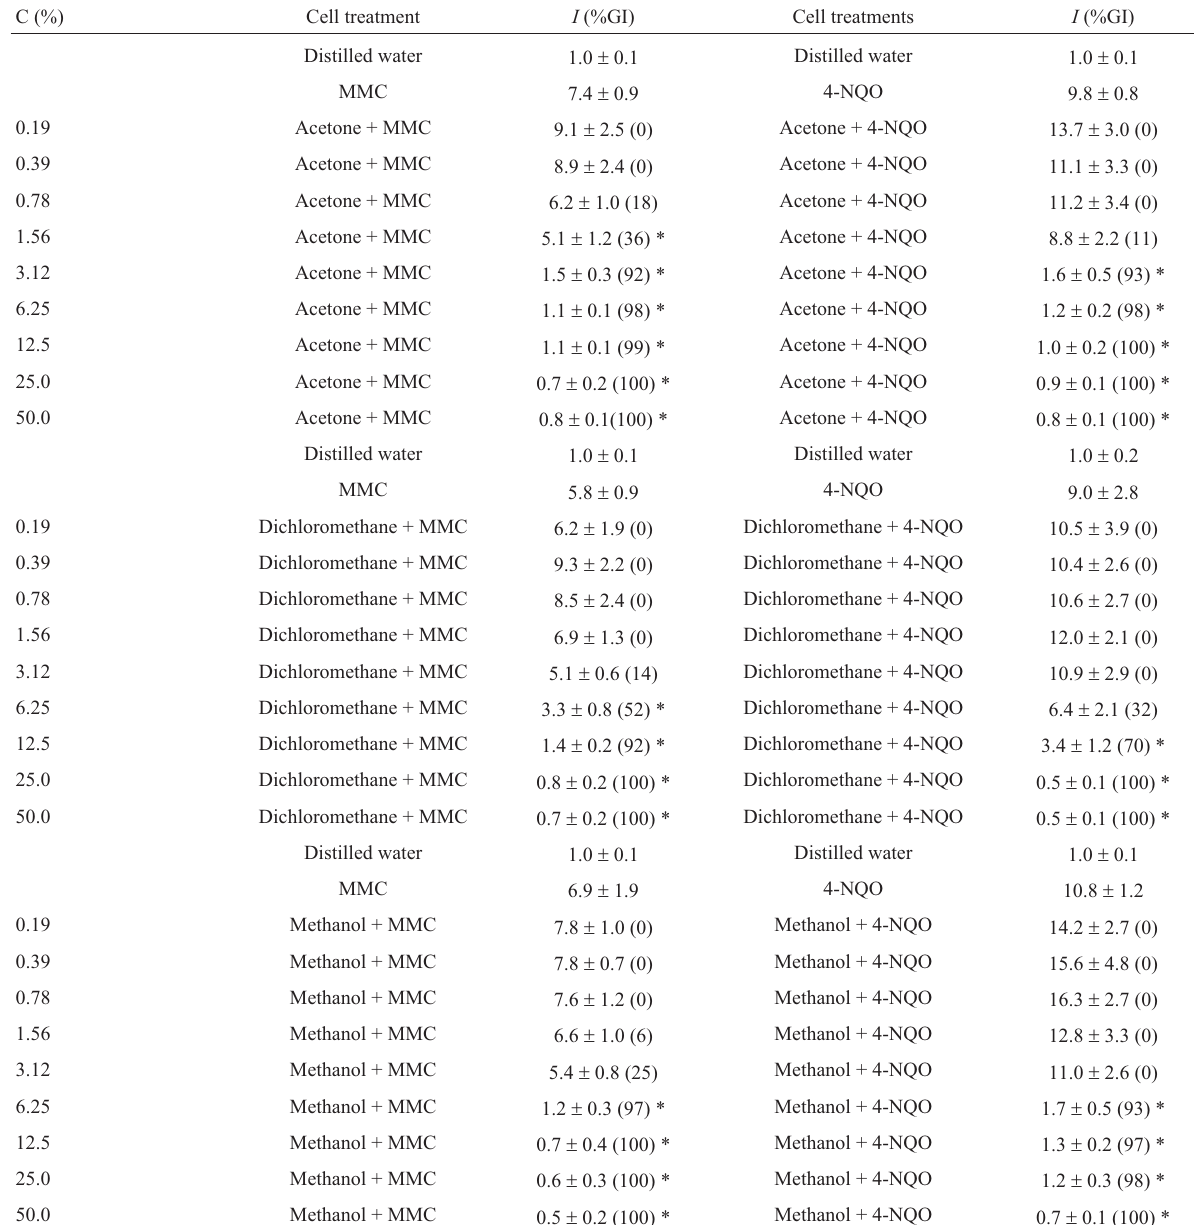
C (%): Solvent concentration in the mixture calculated from the percentage purity of each solvent indicated in Table 1. MMC and 4-NQO were assayed at concentrations of 0.187 (cid:5) M and 2.34 (cid:5) M, respectively. The values are the mean (cid:9) SEM of three independent experiments with four replicates each. The percentage of genotoxicity inhibition (%GI) was calculated as described in the Methods. *p < 0.05 compared to the corresponding positive control (Stu- dent’s t